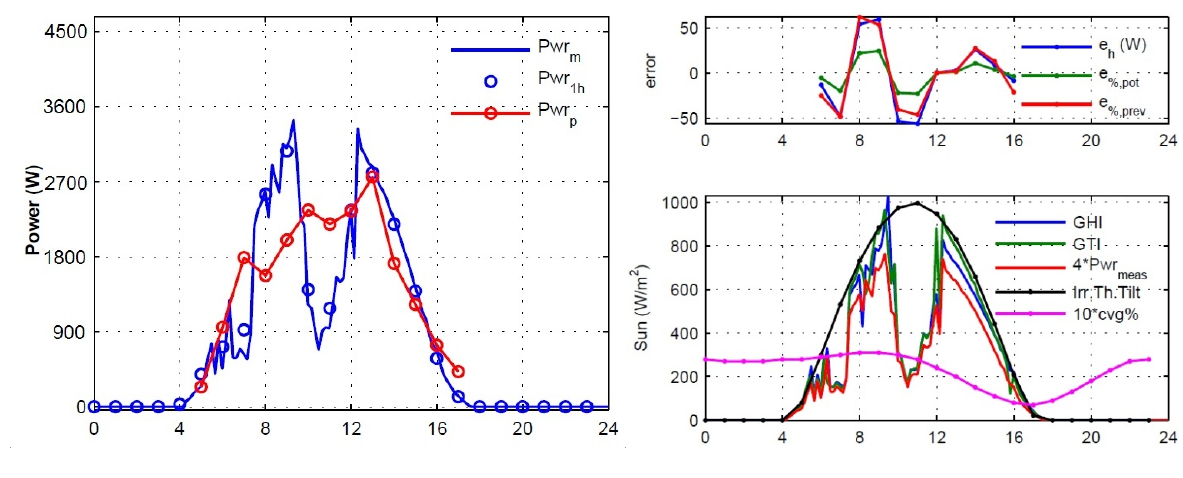
Figure 5. Daily produced and predicted energy comparison.